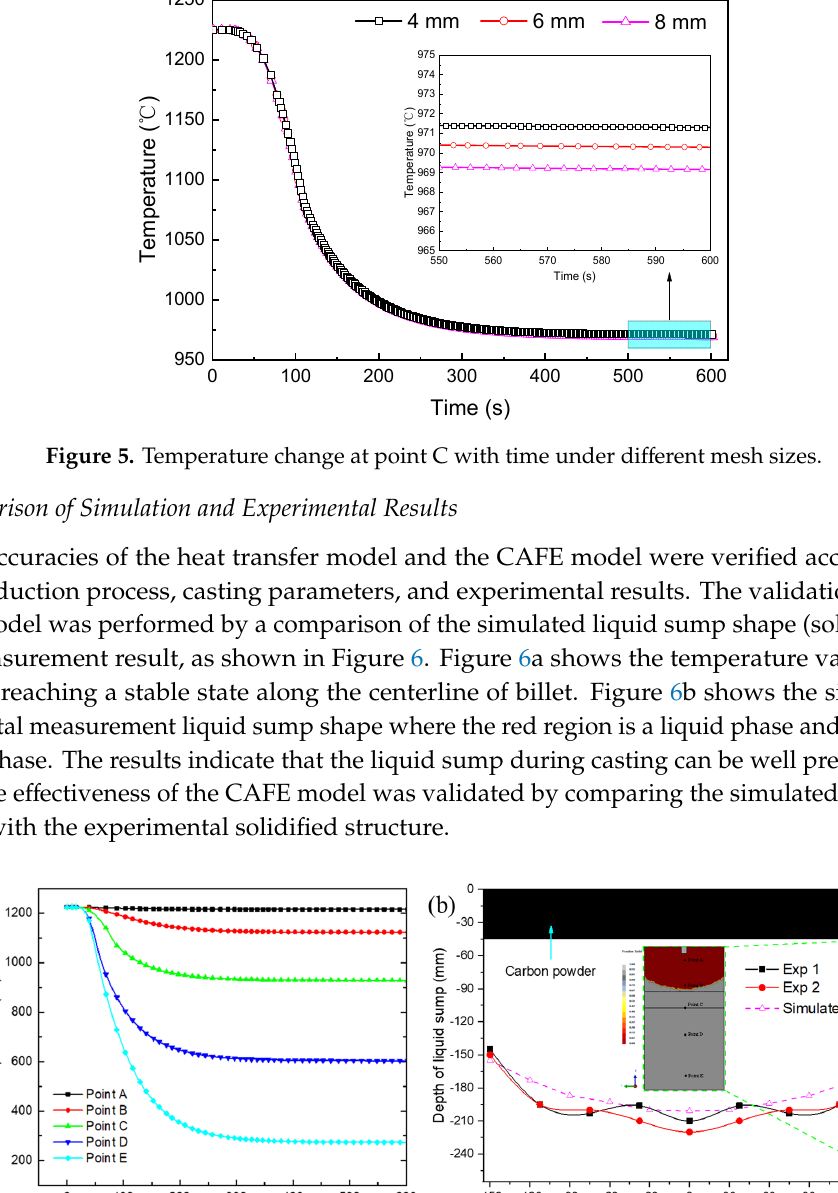
Figure 6. The temperature variation in the process of reaching a stable state along the centerline of billet ( a ), simulated and experimental measurement liquid sump shape ( b ).